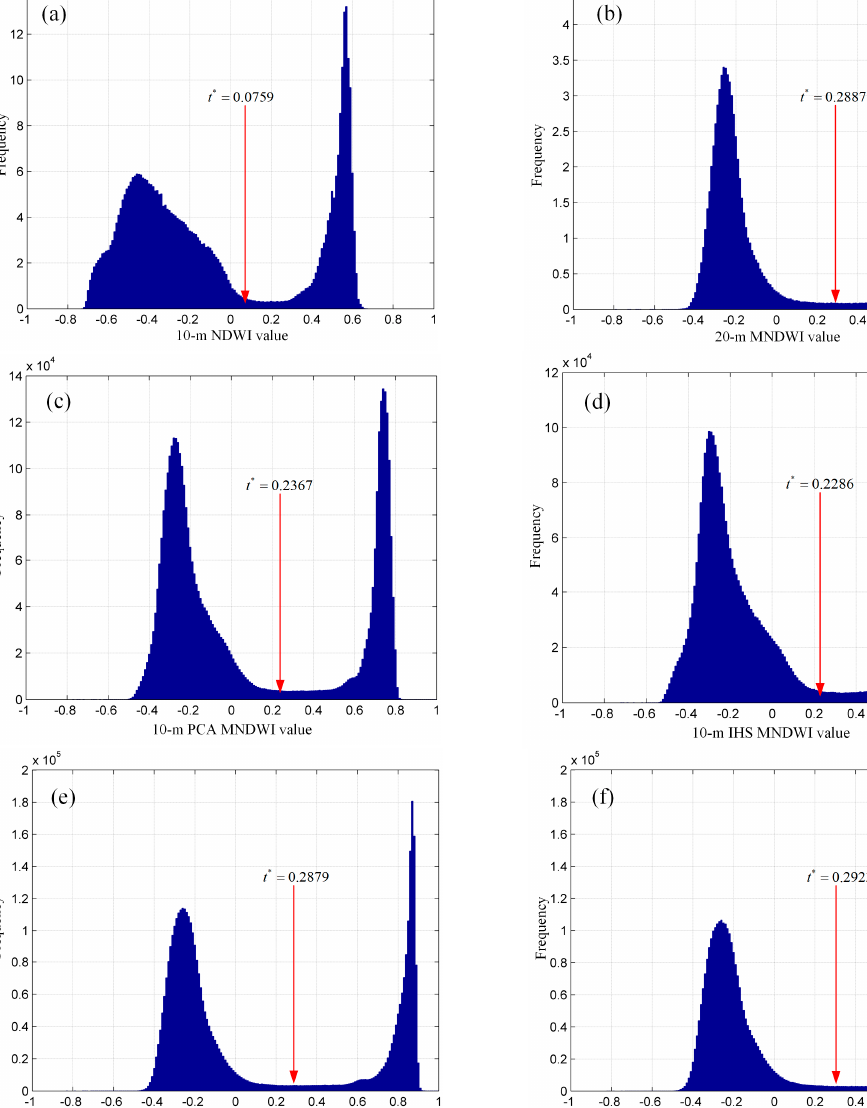
Figure 5. The histograms and optimal threshold values calculated by the OTSU method for the: ( a ) NDWI 10m ; ( b ) MNDWI 20m ; ( c ) MNDWI PCA